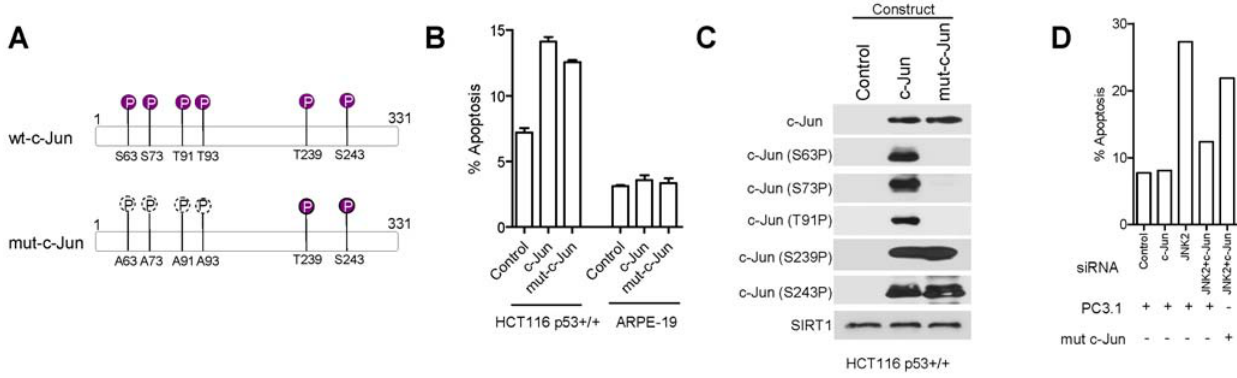
Figure 7. c-Jun overexpression induces apoptosis in HCT116 p53 + / + cells but not in ARPE-19 cells. (A) Schematic showing wild type c- Jun (wt-c-Jun) and non-phosphorylatable mutant c-Jun constructs. (B) Annexin V measurement of apoptosis following overexpression of wt-c-Jun or mut-c-Jun as indicated. (C) Immunoblots showing total and phosphorylated c-Jun following overexpression, SIRT1 loading control shown. (D) Levels of apoptosis following combined siRNA treatment in the presence or absence of non-target mut-c-Jun, (see materials and methods).